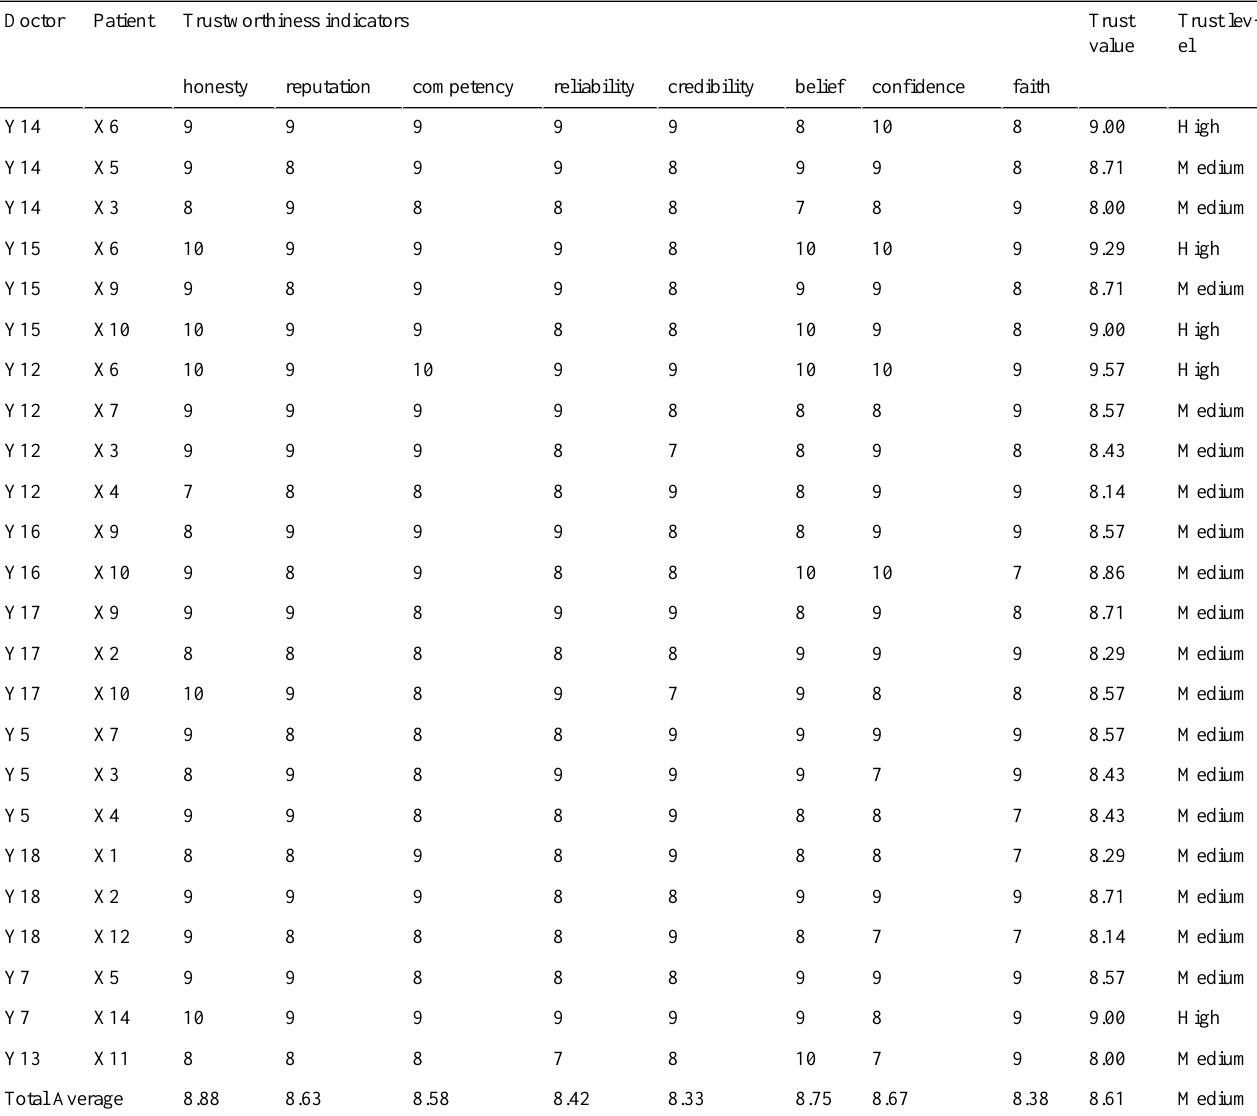
Table 9. Patient ratings of articles posted by physicians on the